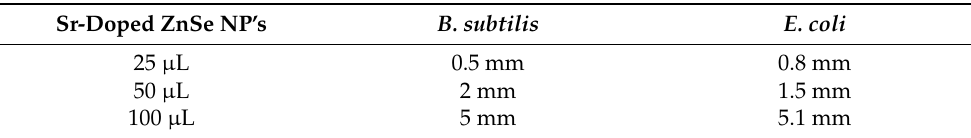
Figure 8. Antibacterial activity of Sr (0.1)-doped ZnSe nanoparticles. Table 1. Antibacterial activity of Sr-doped ZnSe